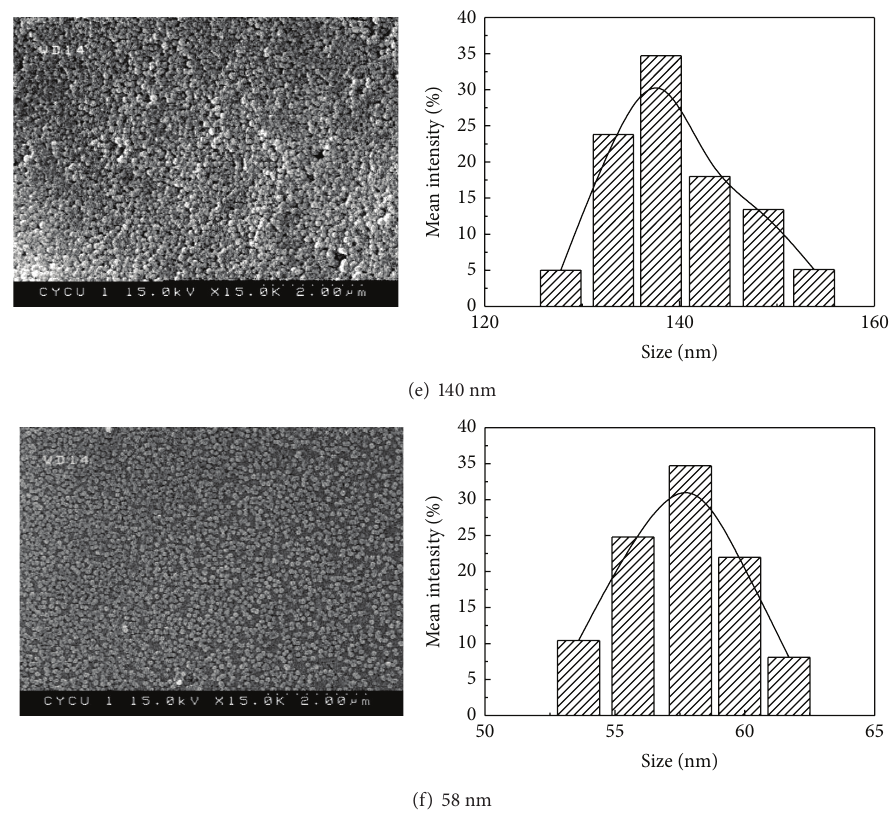
Figure 3: SEM micrographs and size distribution of SiO 2 nanoparticles.